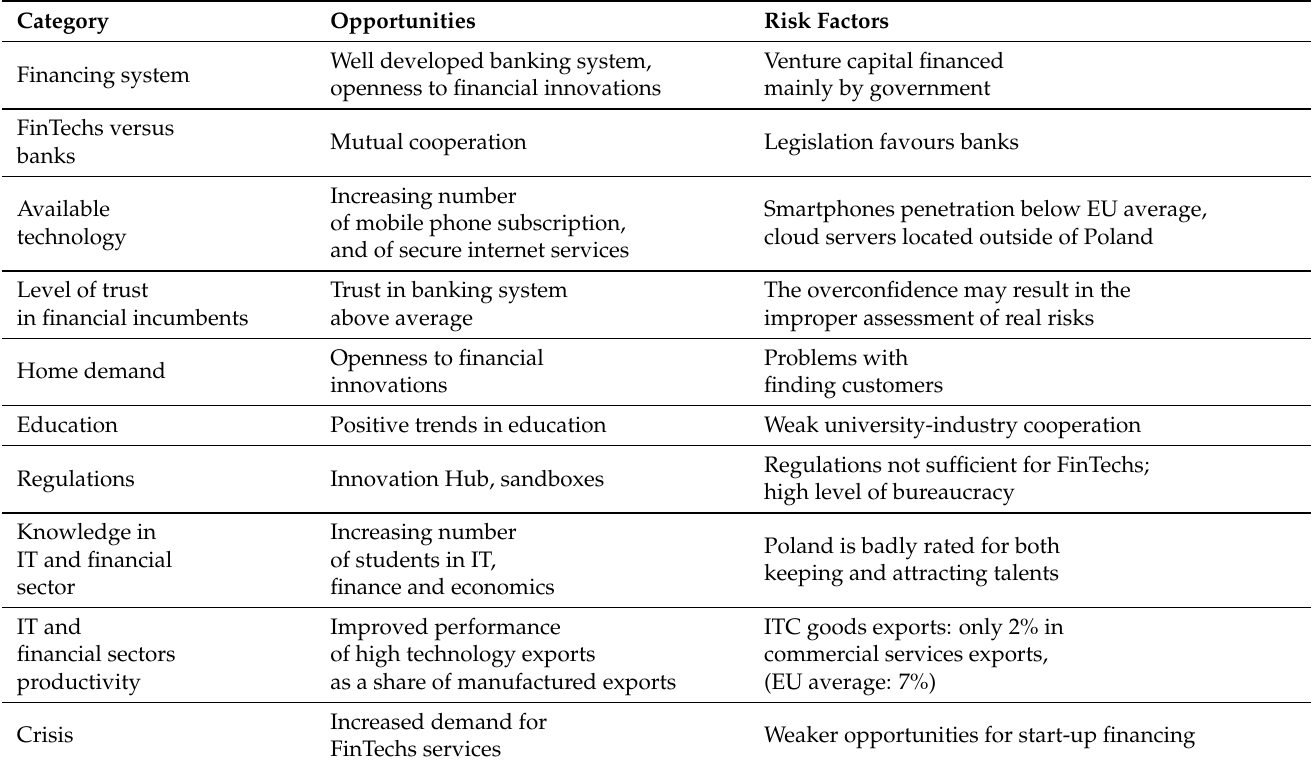
Table 8. Factors supporting and posing the risk to FinTech formation and development in